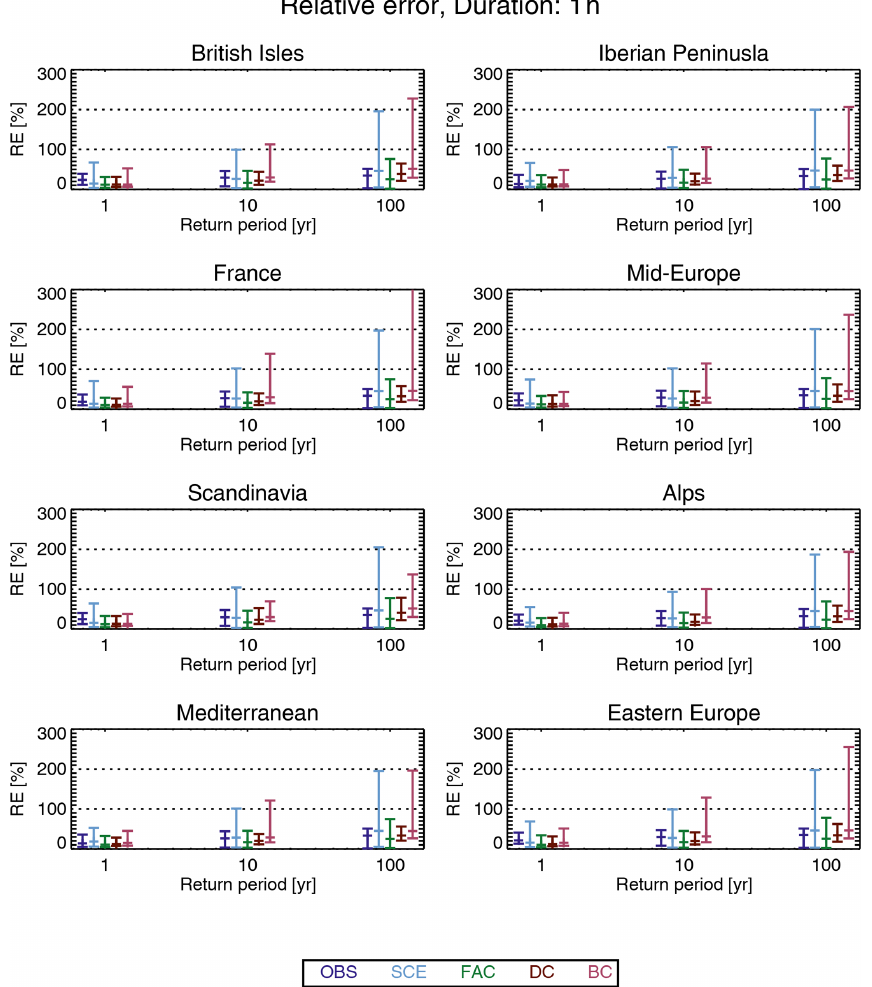
Figure 6. Statistical distribution (median and 5th and 95th percentile) of the relative error of the inter-model cross-validation for a 1h duration for 1, 10 and 100-year return periods. Panels represent the PRUDENCE subregions shown in Fig. 1. Each colour represents an adjustment method (see Table